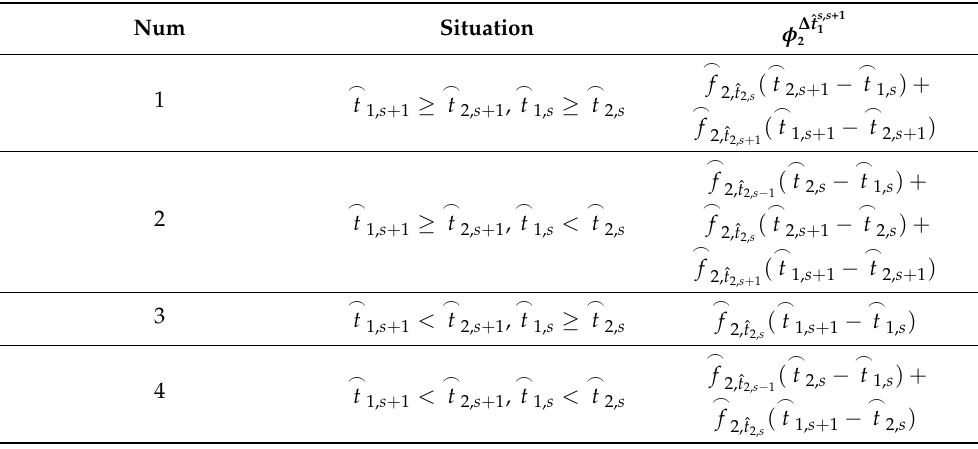
Table 3. Four-time distributions of discrete points of